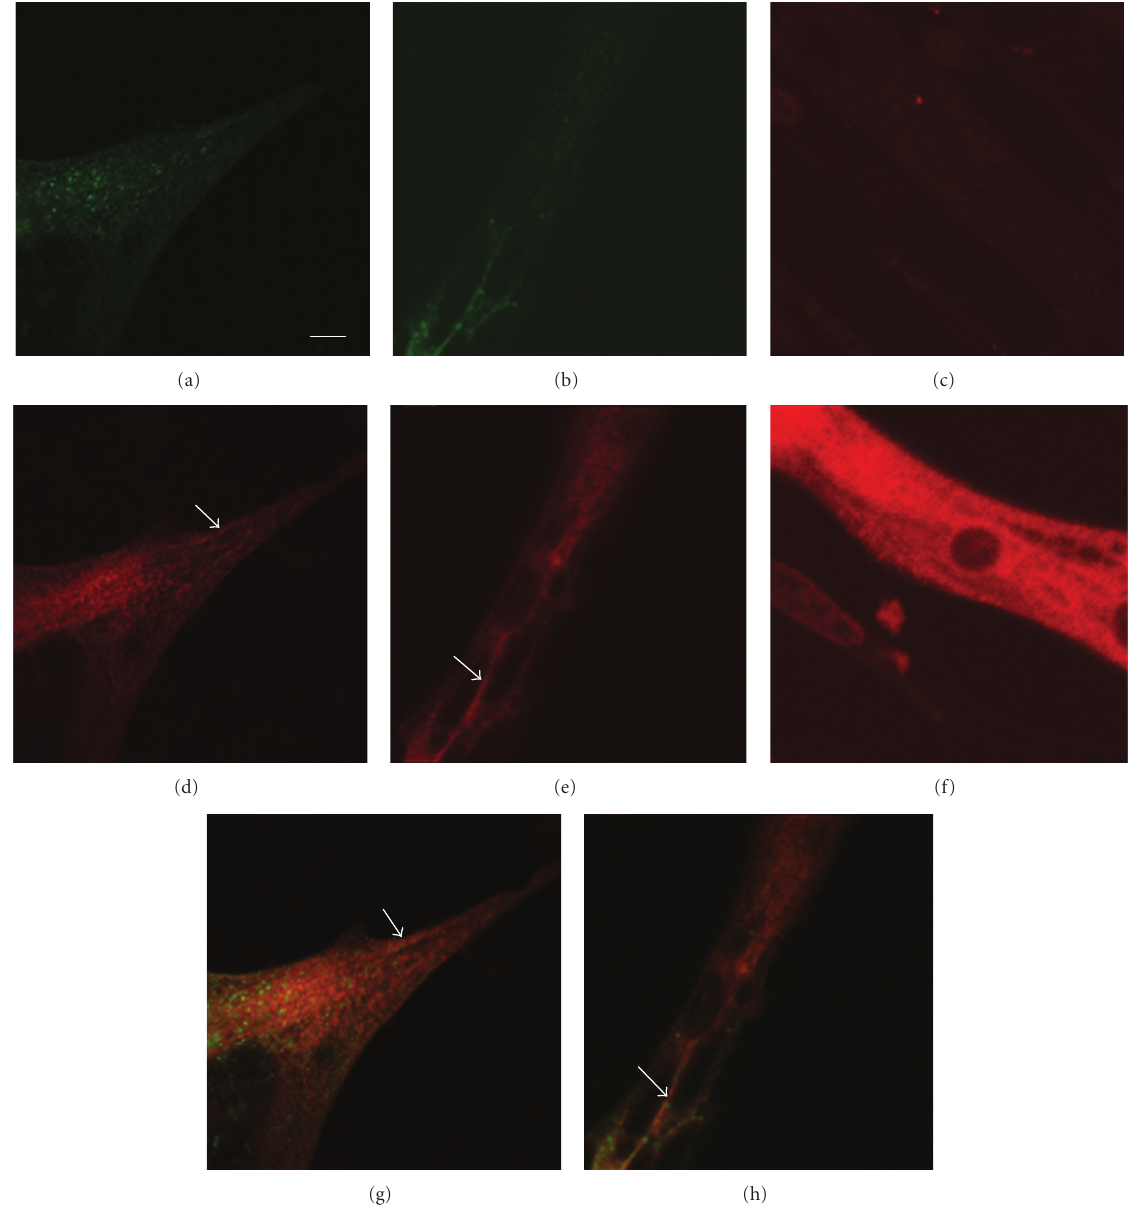
Figure 5: Ca v 1.1 AA is targeted to T-SR junctions. Confocal images of colocalization of either YFP-Ca v 1.1 (a) or YFP-Ca v 1.1 < ? erm ? >AA< ? erm ? > (b) green fluorescence and immunolabeled RyR1 ((d) and (e)) red fluorescence in dysgenic myotubes. (g) and (h) represent overlay of (a) and (d), and (b) and (e), respectively. The control dysgenic myotube (no Ca v 1.1) immunolabeled without (c) and with (f) primary Ab(34C). Bar, 20 μ